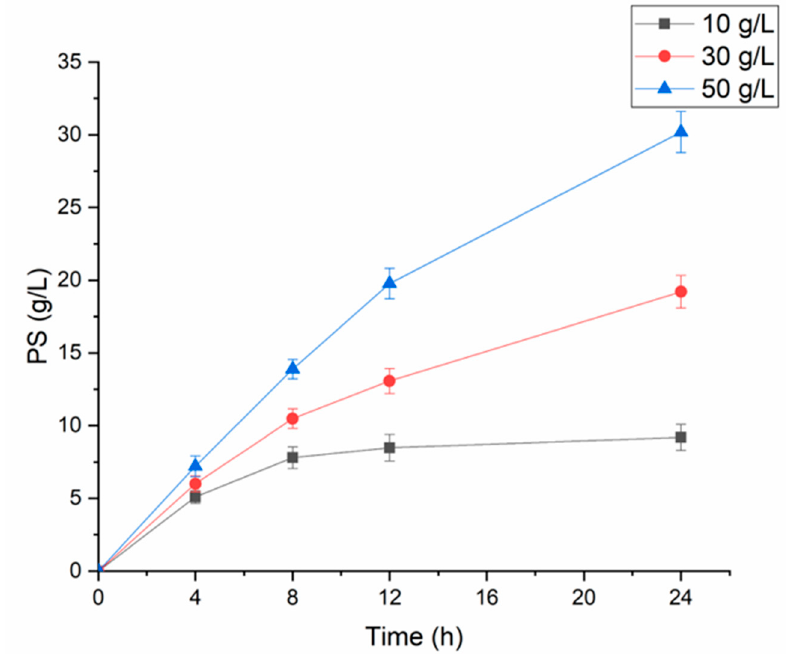
Figure 6. Using the recombinant PLD PMF for the bioconversion of PC to PS.